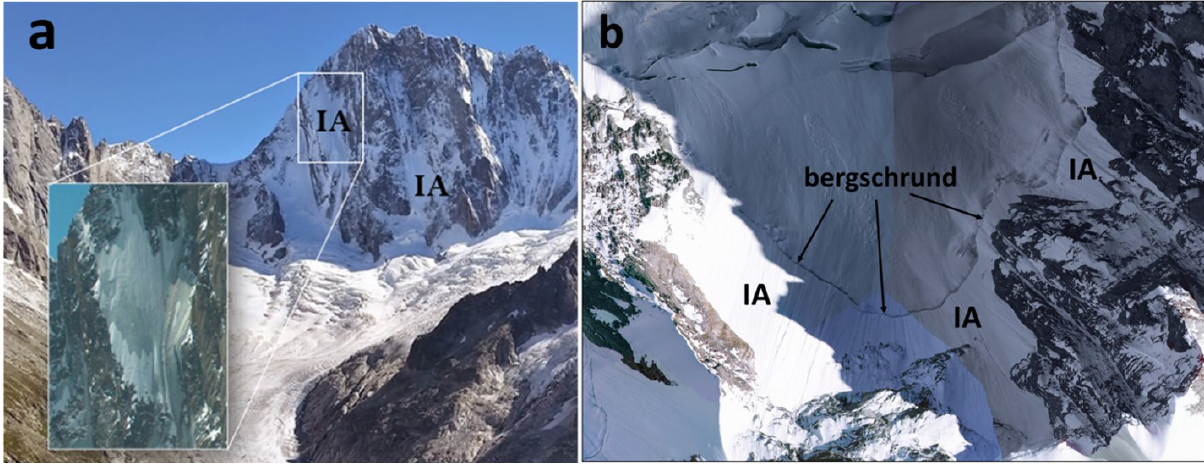
Figure 2. Ice aprons and their locations in the MBM: (a) IAs on the N face of Grandes Jorasses (4208ma.s.l.), photograph courtesy Ludovic Ravanel, and (b) IAs on the headwall of the Argentière glacier separated by a bergschrund (3280ma.s.l.), IGN orthophotos 2015. Table 1. Datasets used for the